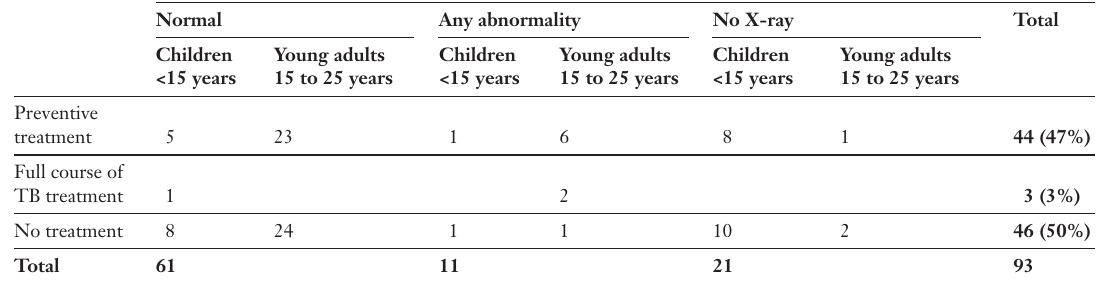
Table 1 Treatment prescribed by age groups and results of radiological examination among 93